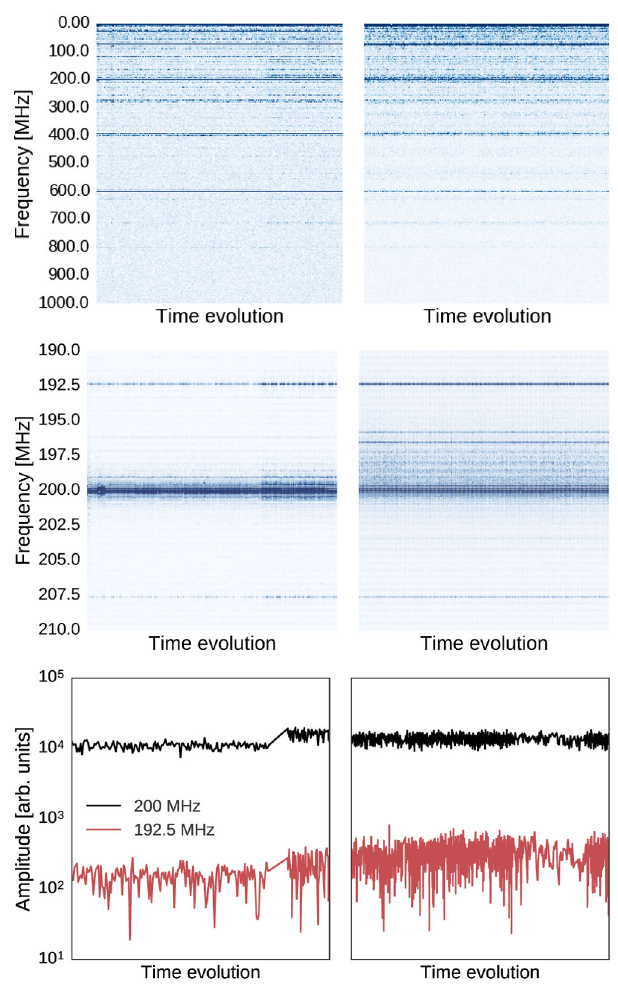
FIG. 24. Amplitudes of frequencies from FFT for CT (left column) and MTE (right column) extracted spills as a function of time. The upper plot shows all frequencies present in the spectrum, while in the center plot a zoom in the region around the 200 MHz component is shown. The bottom plot shows the evolution over time of the 200 MHz and of the 192.5 MHz components only.